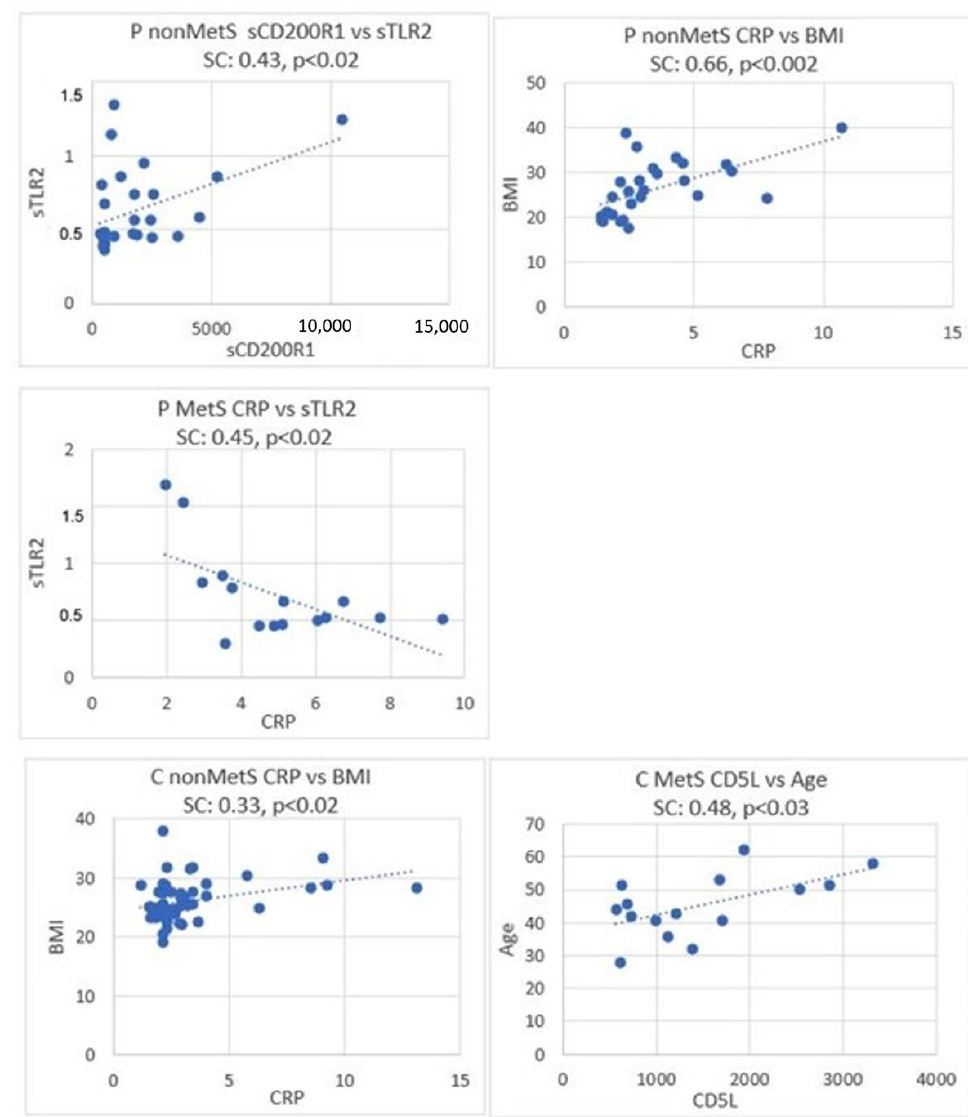
Figure 5. Scatter plots illustrating the correlations between measured parameters, both in groups of controls and patients and in subgroups. Dots represent the values of measured markers of each participant.